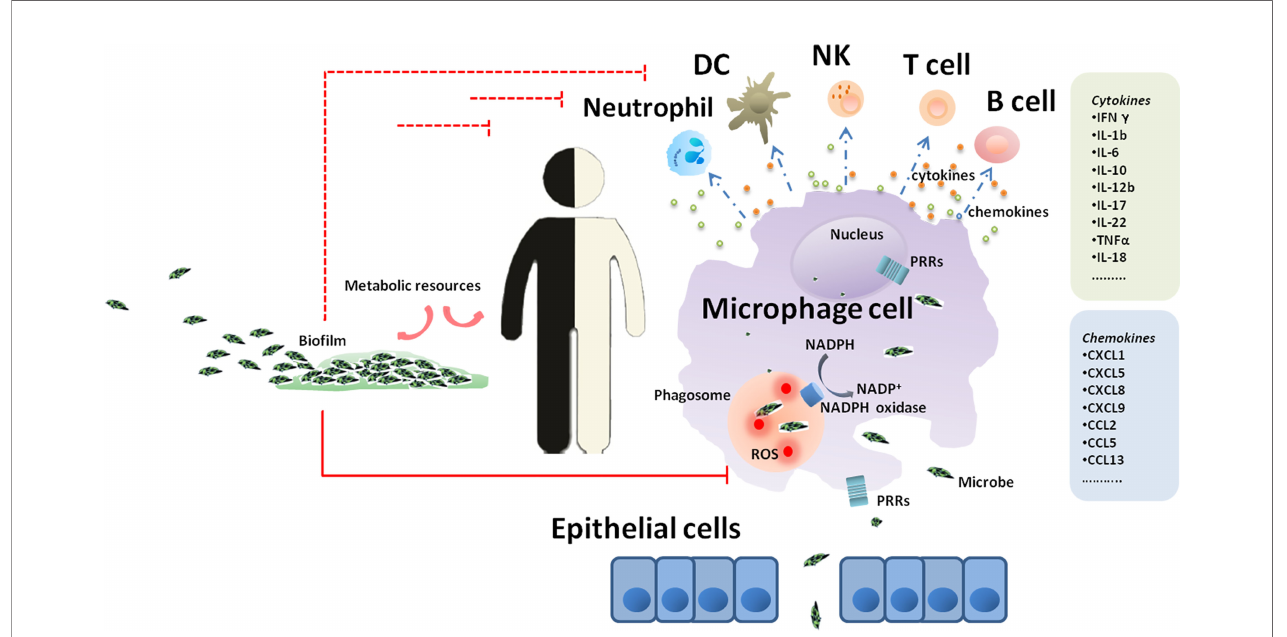
FIGURE 1 | A journey of GI microbes in the host. Epithelium is the gateway for the introduction of GI microbes inside the host and subsequent progression of GI diseases. Once microbes get through the gateway, the process of phagocytosis is initiated, and macrophages are the fi rst line of defense. In macrophages, invading microbes are engulfed by phagocytosis into phagosomal structures and encounter a complex and dynamic range of host defenses. The recognition of bacterial antigens by a range of pattern recognition receptors expressed by macrophages triggers a signaling cascade leading to the recruitment of a diverse cell type complement including neutrophils, dendritic cells, natural killer cells, T lymphocytes and B